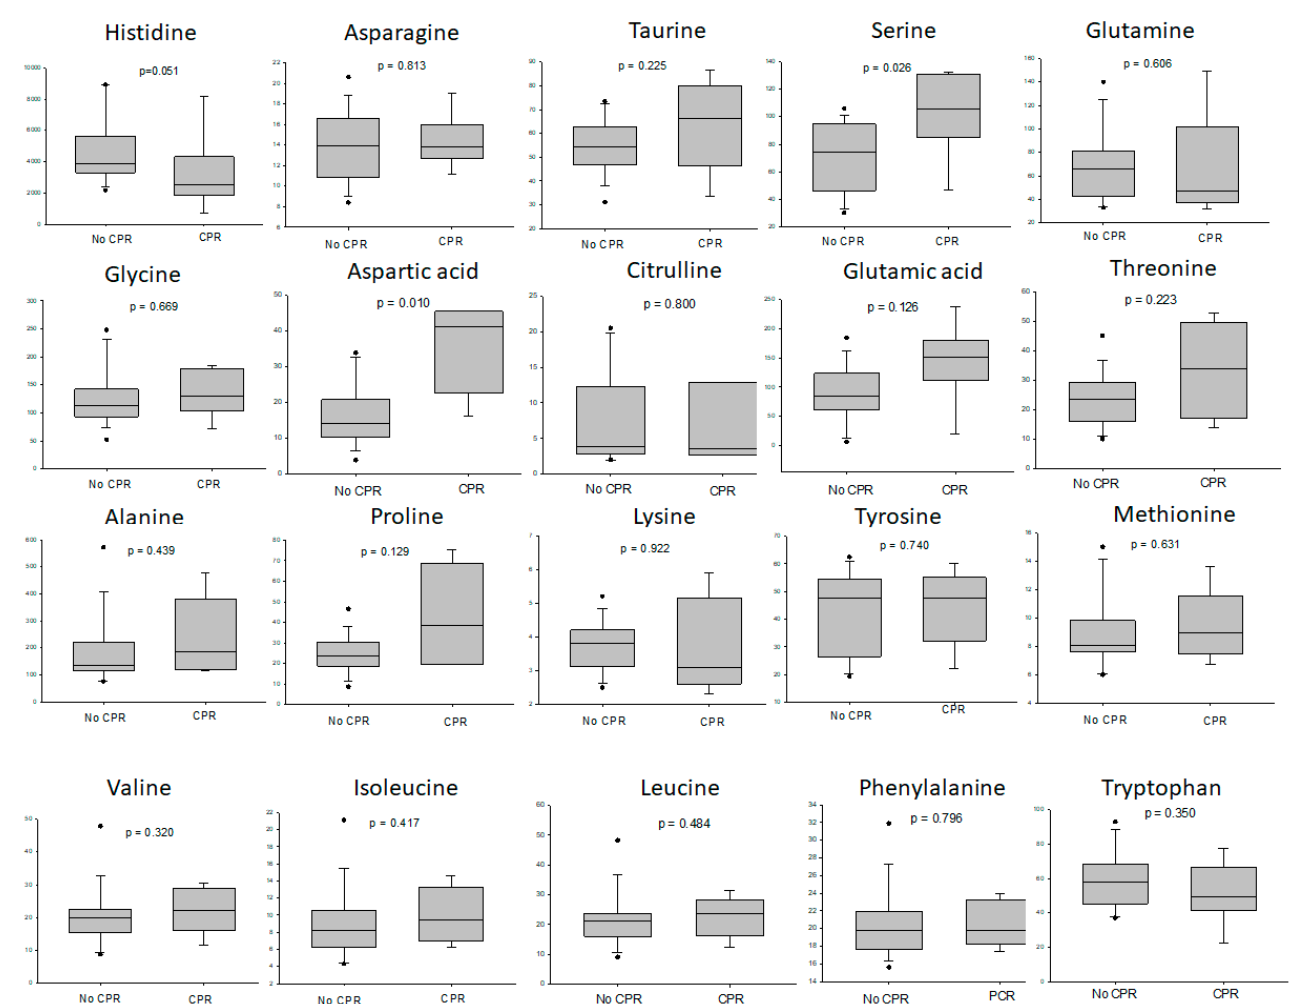
Figure 5. The difference of amino acid between the deceased donors with or without CPR. The liver grafts from the donors with CPR had higher levels of serine, aspartic acid and proline than the liver grafts from donors without CPR.